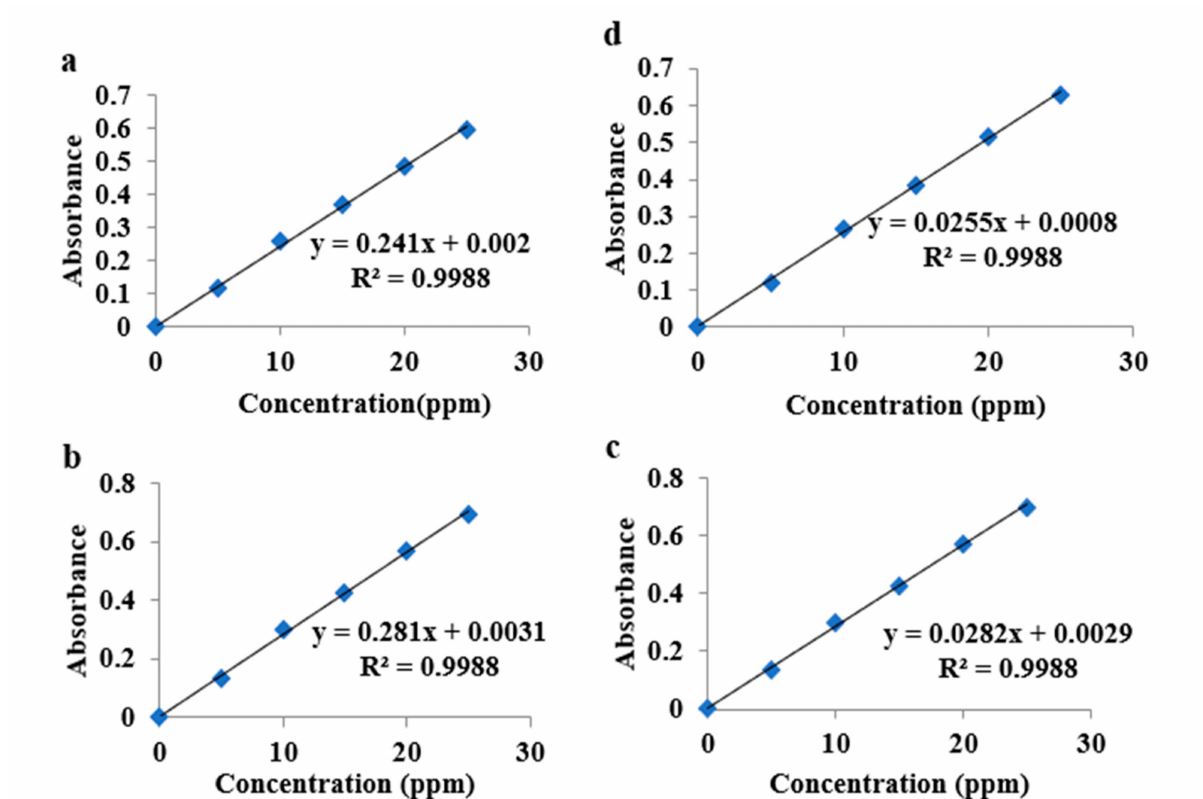
Figure 1. Standard calibration curve for the determination of lycopene and β -carotene (( a ) is absorp- tion at 451 nm, ( b ) = 472 nm, ( c ) = 485 nm, and ( d ) = 502 nm wavelength,